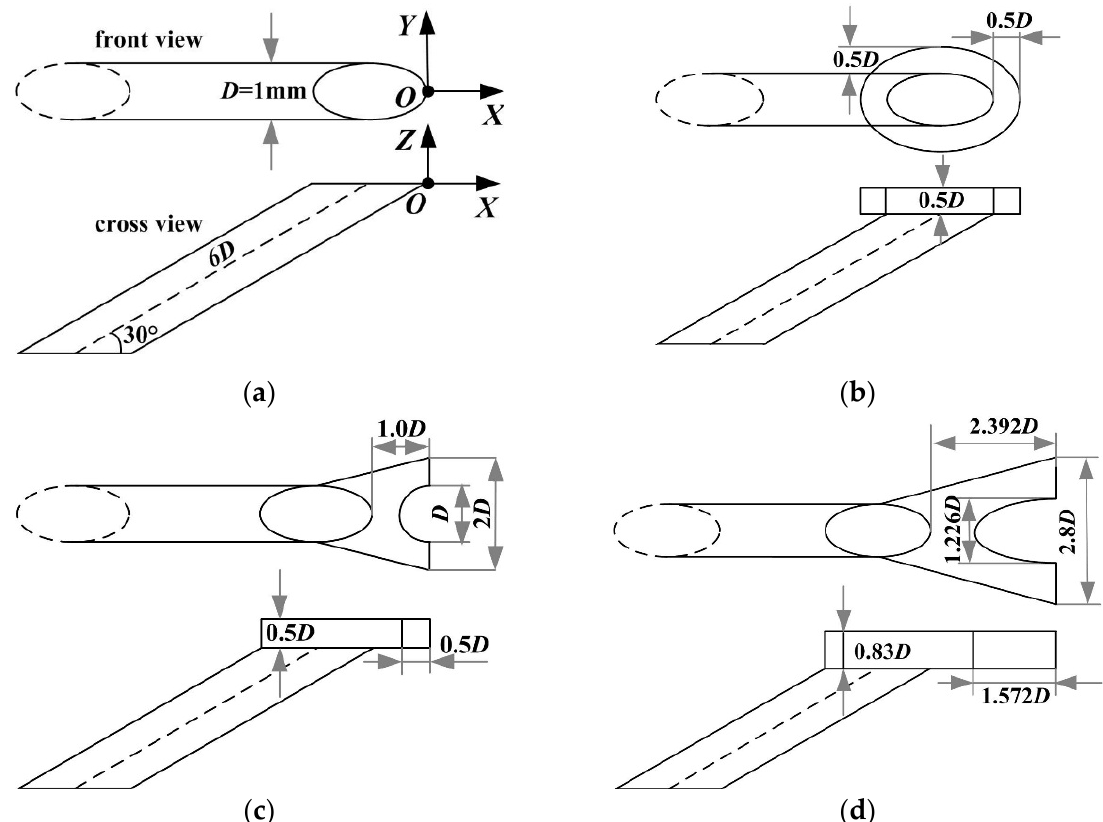
Figure 1. Film cooling holes investigated. ( a ) cylindrical hole (CYL); ( b ) circular cratered hole (CIR_CRA); ( c ) contoured cratered hole (CRA1); ( d ) contoured cratered hole (CRA2).